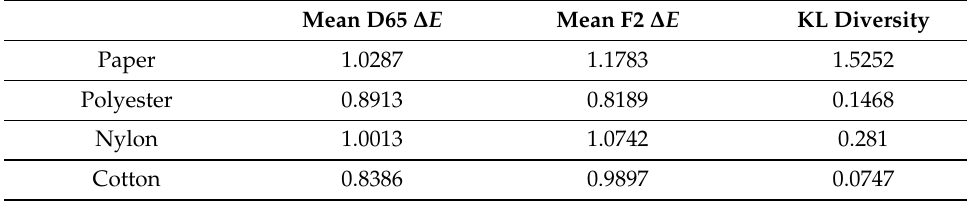
Table 4. One material as training and the rest as